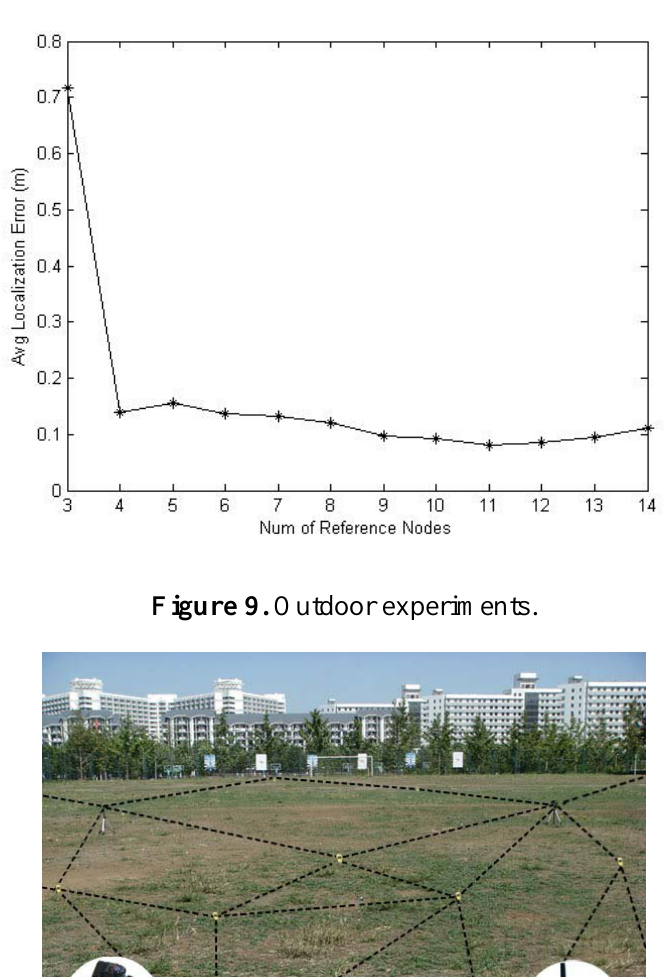
Figure 8. Non-metric MDS performance.